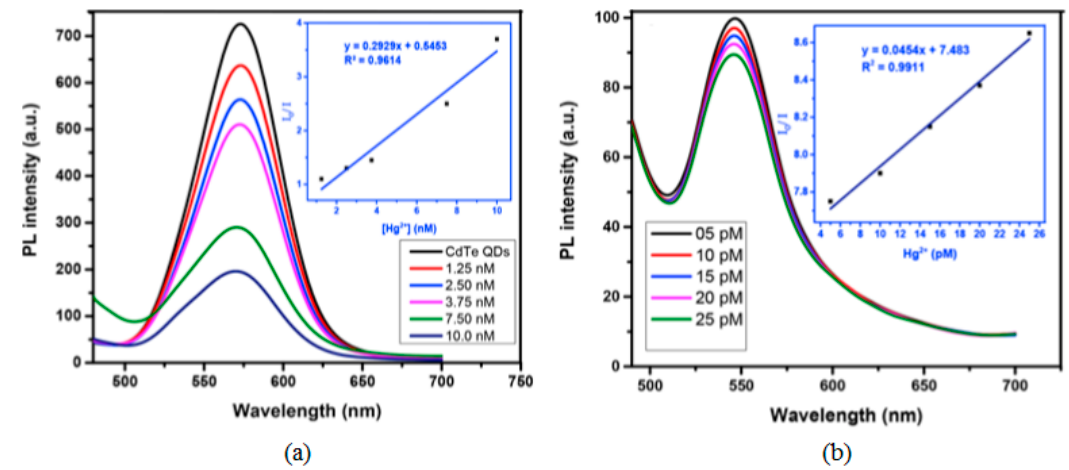
Figure 8. Fluorescence spectra of ( a ) TGA and ( b ) L-cysteine capped CdTe QDs for Hg 2+ concentrations in the nanomolar and picomolar ranges, respectively. Reprinted with permission from [109].